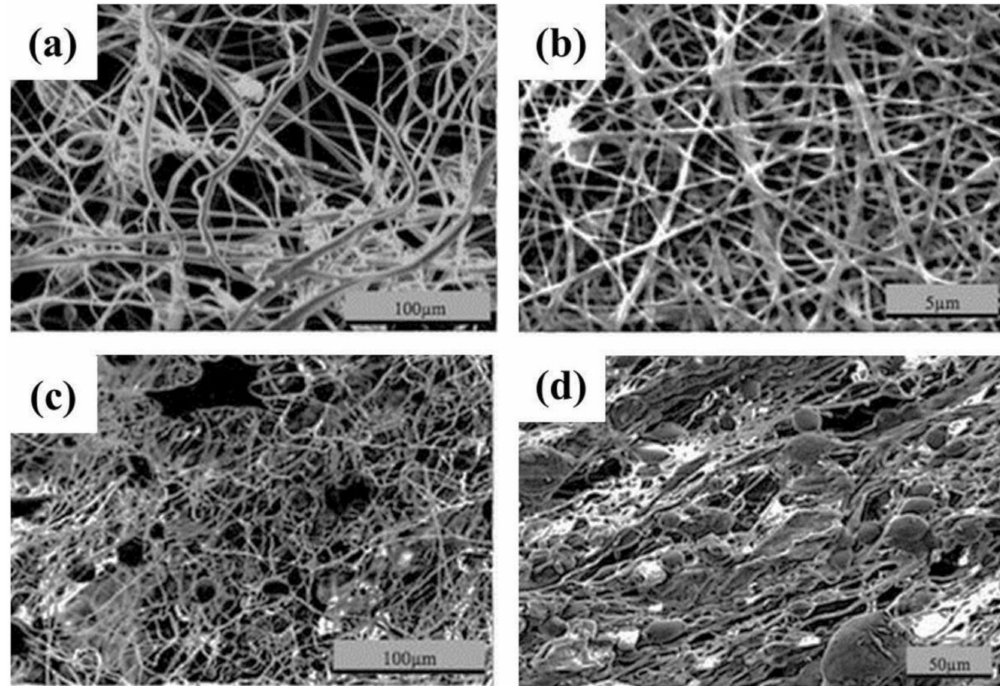
Figure 12. SEM images of ( a ) 1.5 L; ( b ) 2.0 L; ( c ) 2.5 L; and ( d ) 3.0 L electrospun nanofibers [197]. Reproduced with permission from ref. [197]. Copyright Springer Nature,